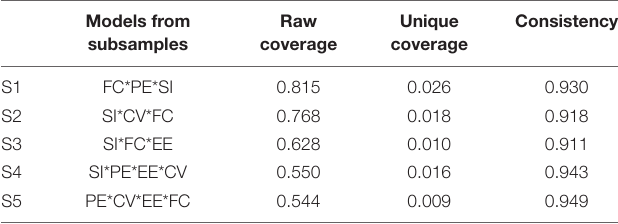
TABLE 9 | Solutions from the subsample. Models from